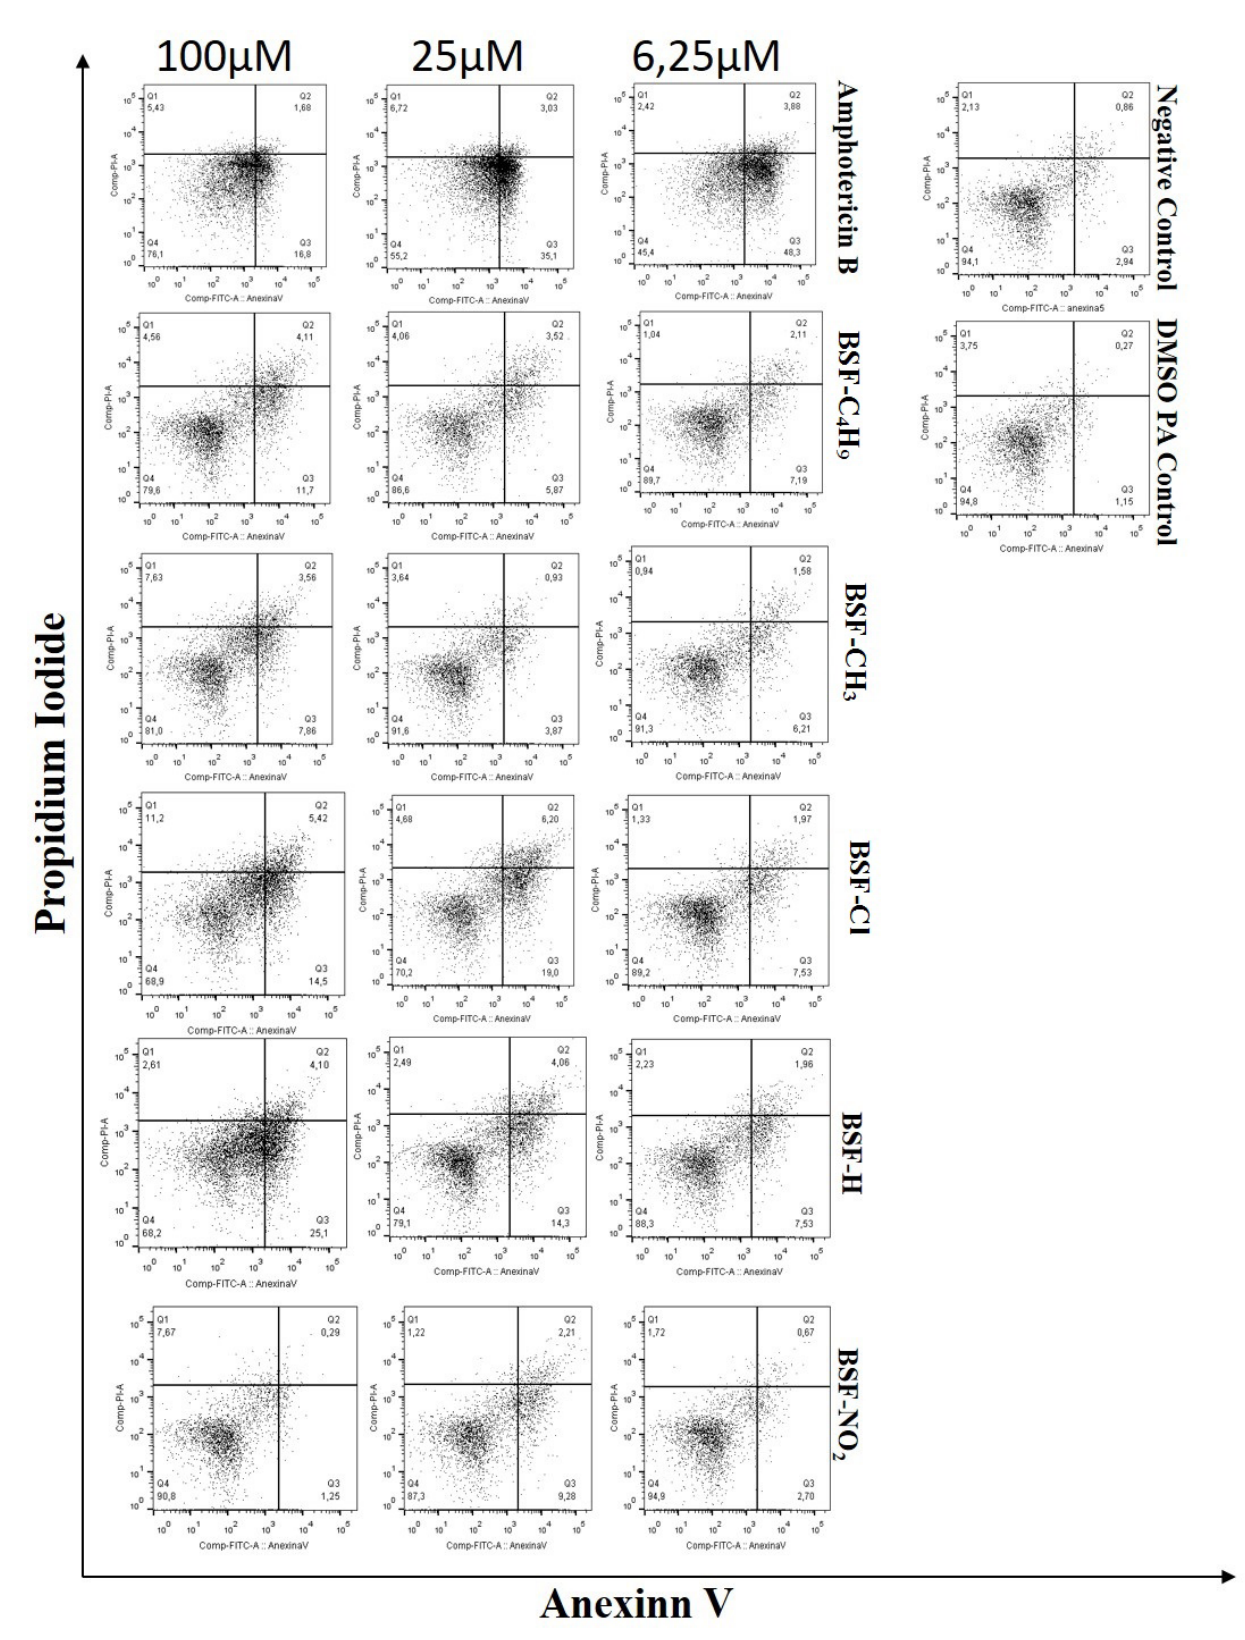
Figure 1 Promastigotes apoptosis determined by Annexin V-FITC staining after treatment with nitro-heterocyclic derivatives and amphotericin B. Flow cytometer analysis of the apoptotic and necrotic cells after incubation of 48 hours in presence of the substituted compounds. Negative Control (untreated) and DMSO PA control. Data are represented in dot-plot. Annexin V -FITC (X axis) and Propidium Iodide (PI) - PE (Y